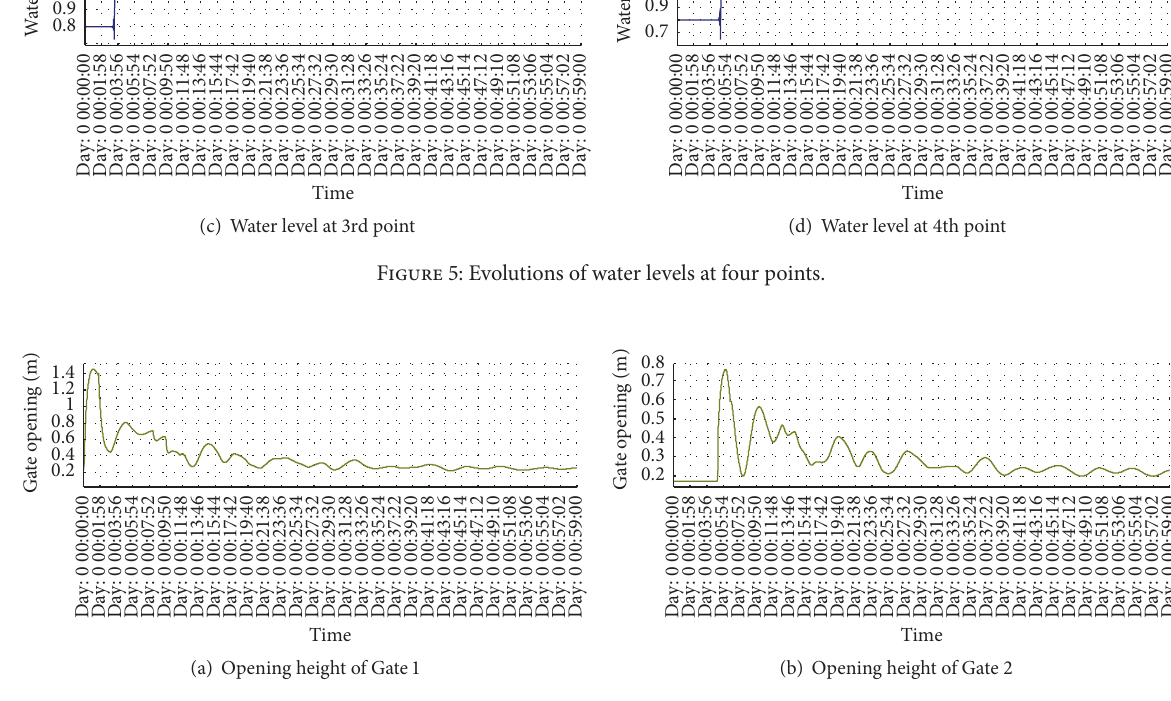
Figure 6: Evolutions of two gate opening heights.